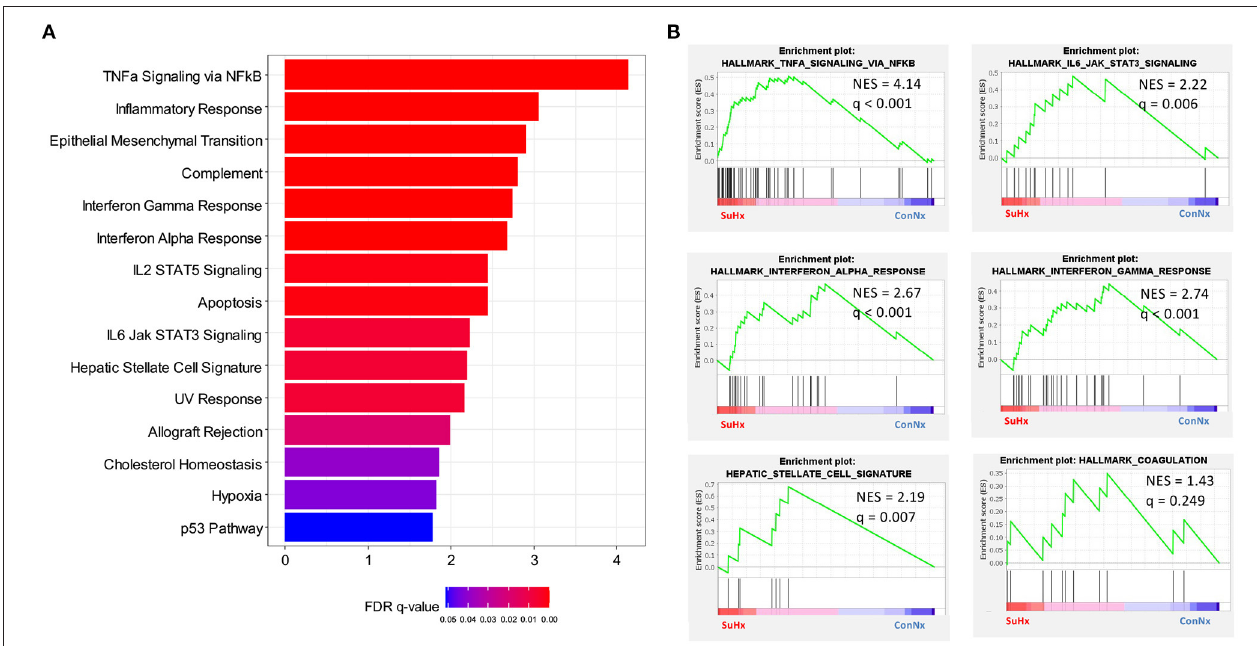
FIGURE 5 | RNA Sequencing reveals inflammatory and fibrotic gene expression in livers of PAH rats. (A) GSEA analysis of differentially regulated genes in SuHx treated rats compared with ConNx control group. Shown are all pathways with FDR adjusted q-values < 0.05. (B) Enrichment plots of select pathways from the GSEA analysis. ConNx n = 3, SuHx n =